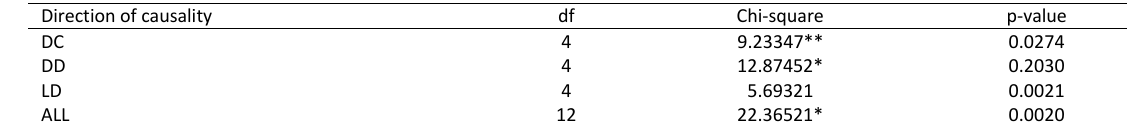
Table 6: The Granger causality test